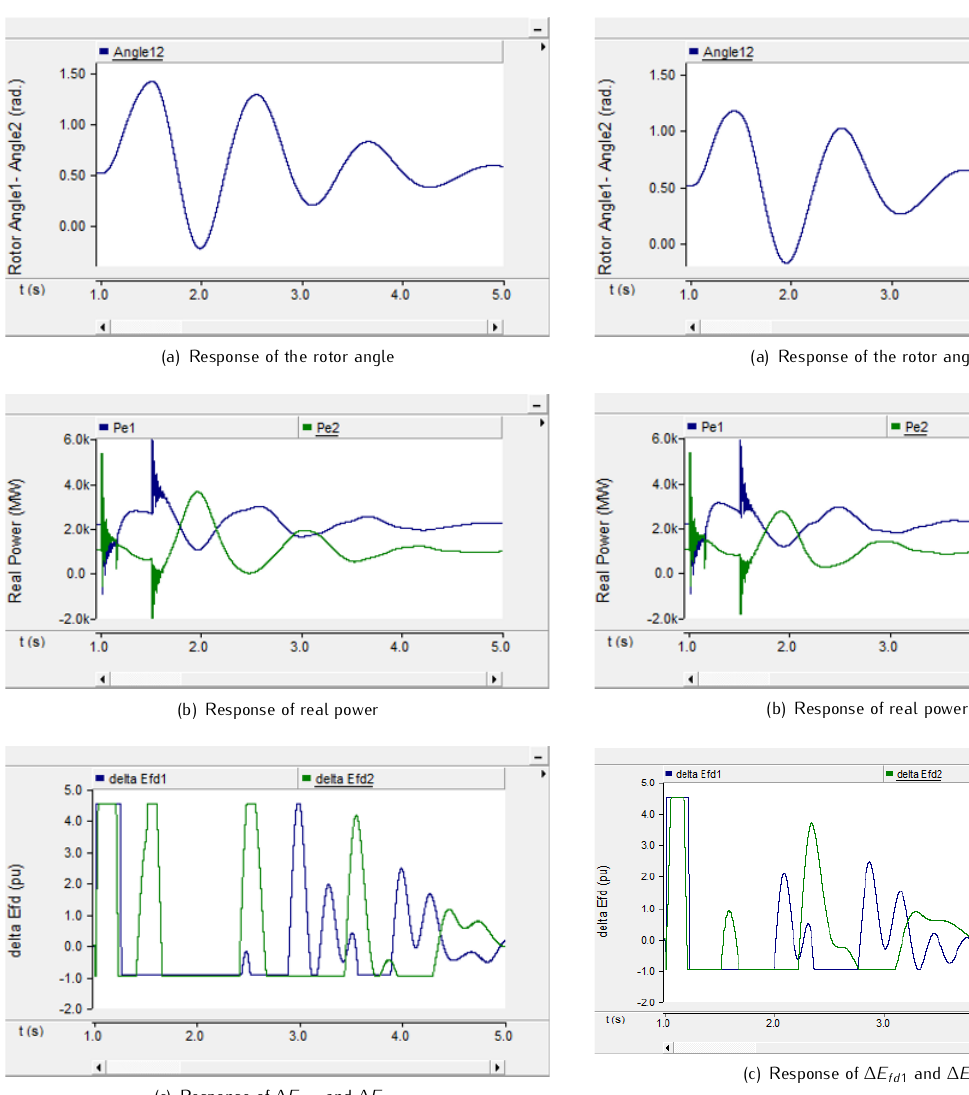
Figure 6 A three-phase fault happened at point f under PSS control